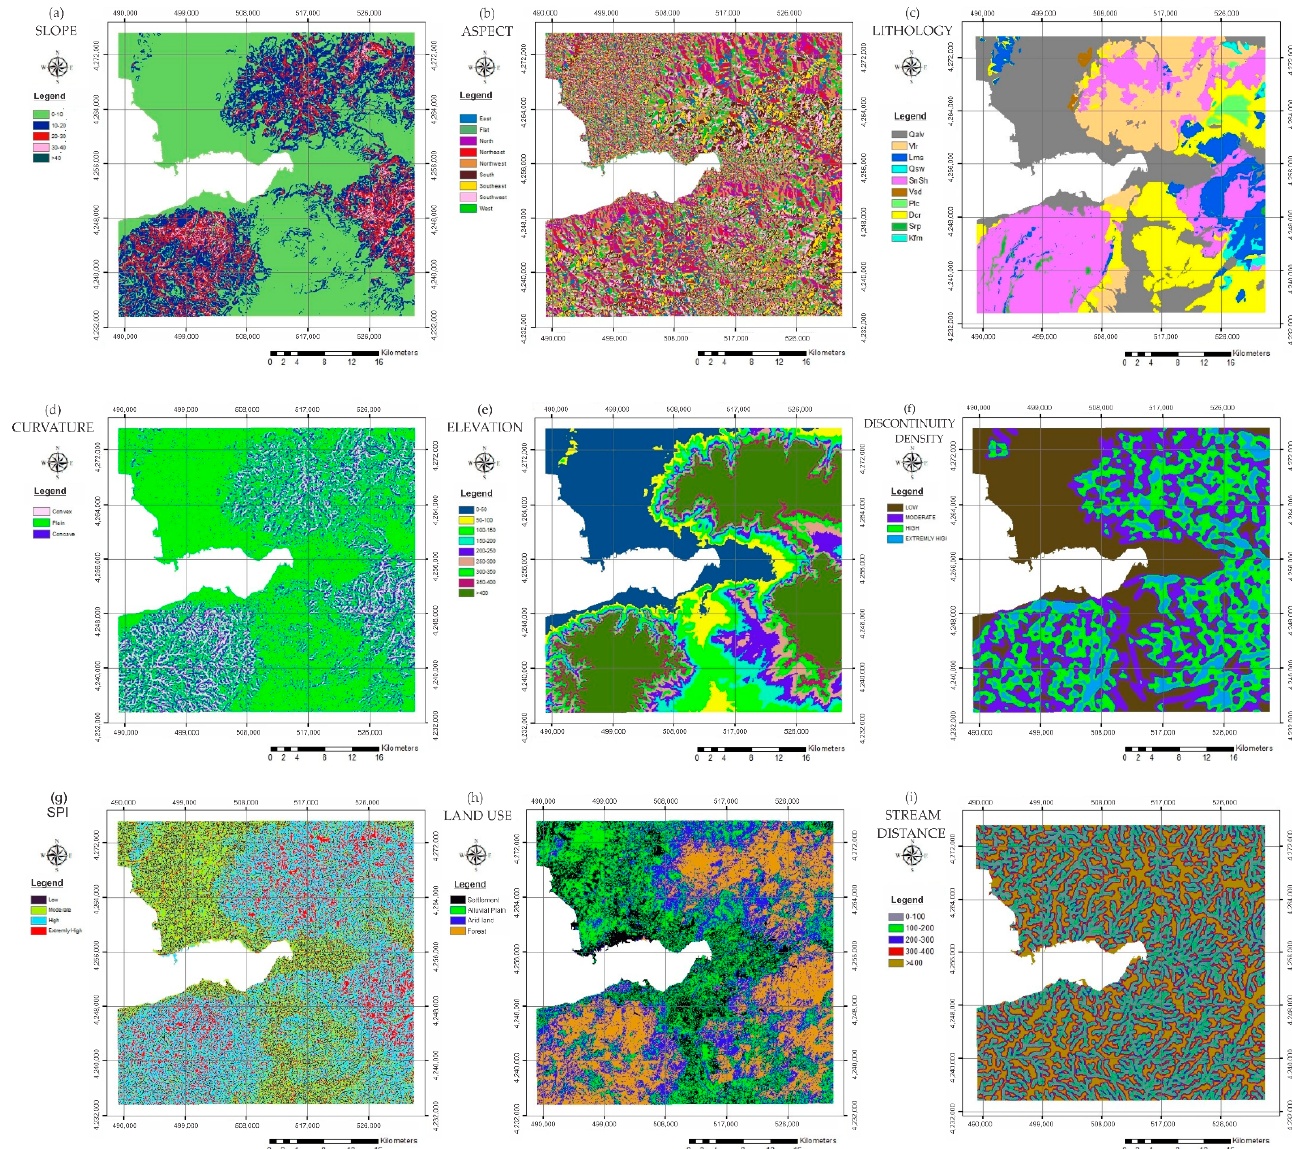
Figure 5. Geo-environmental factors: ( a ) slope, ( b ) slope aspect, ( c ) lithology, ( d ) slope curvature, ( e ) elevation, ( f ) density of discontinuity, ( g ) SPI, ( h ) land use, ( i ) distance from stream. A 1/25,000 scale geological map of GDMRE, a 1/25,000 scale topographical